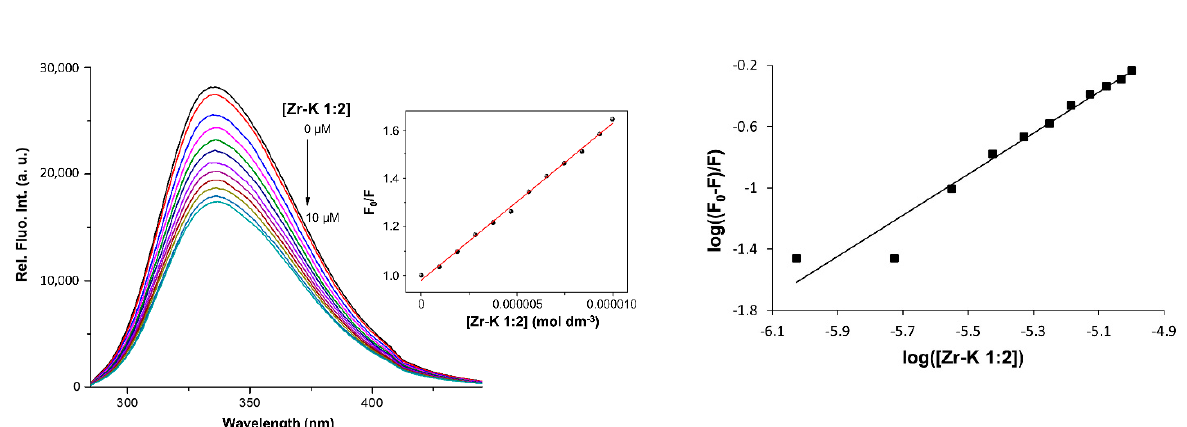
Figure 5. Emission spectra ( left ) of 10 µ M OVA (in 10 mM sodium phosphate buffer at pH 7.4) in the absence or presence of different concentrations of Zr-K 1:2, which was increased from 0 µ M (top spectrum) to 10 µ M (bottom spectrum). The inset shows the Stern–Volmer plot where the ratio of unquenched ( F 0 ) to the quenched fluorescence intensity ( F ) was plotted as a function of the concentration of Zr-K 1:2 ([Zr-K 1:2]). Derived Stern–Volmer plot ( right ) of log(( F 0 − F )/ F ) vs. log([Zr-K 1:2]) used to calculate the association constant ( K a ) and the number of binding molecules ( n ).